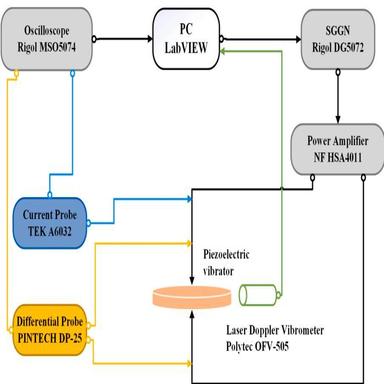
Schematic diagram of the high-field impedance spectrum measuring system.